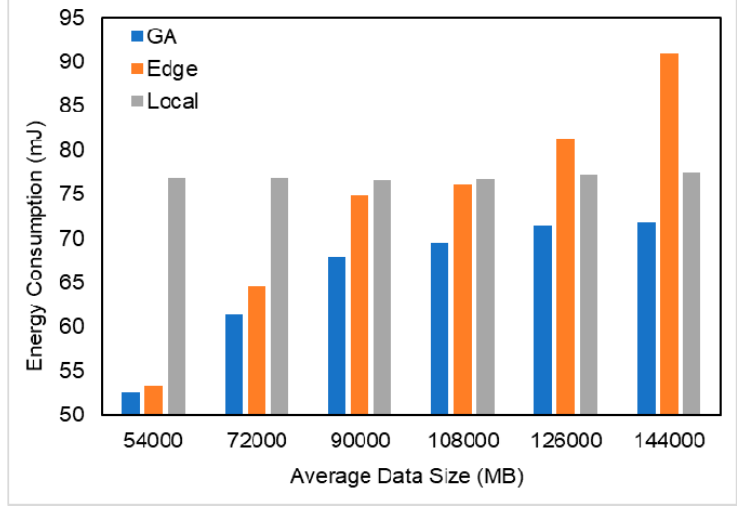
Figure 6. The impact of the edge cloud cache size on energy consumption.